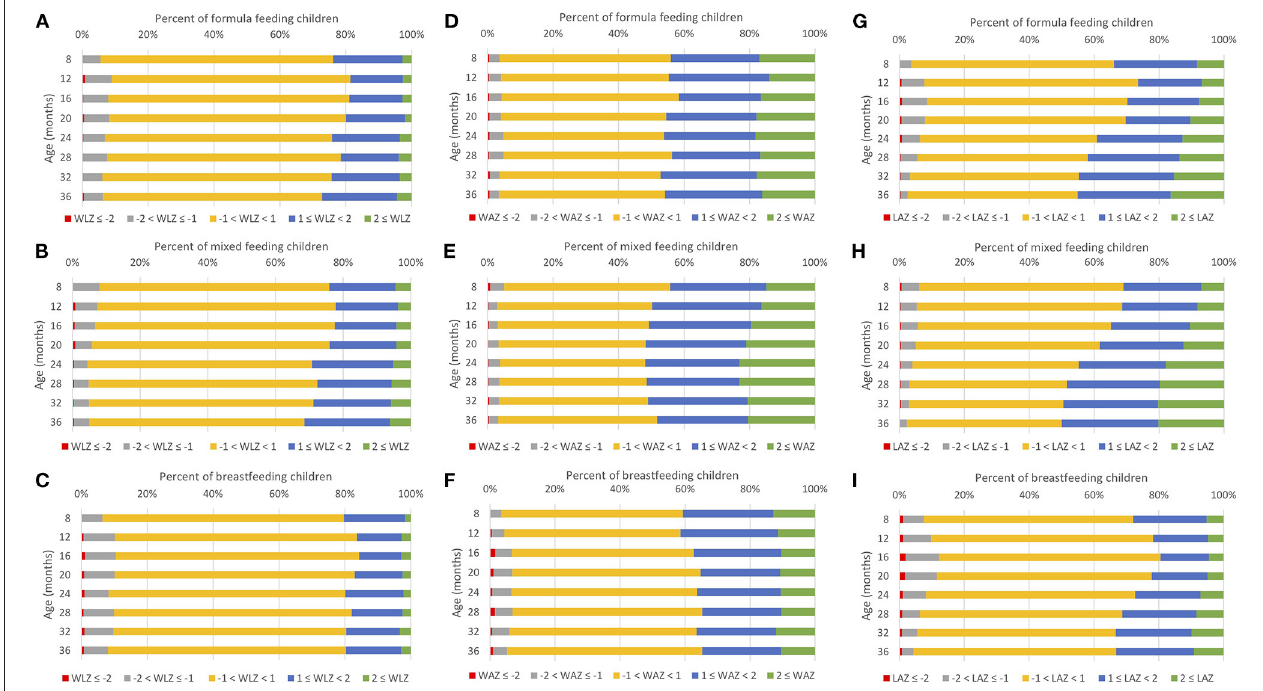
FIGURE 1 | Prevalence of anthropometric index percentile categories a by infant package received at 7 months for WIC-participating children from ages 7 to 38 months in Los Angeles County, 2009–2016 ( N = 16,255). (A) Formula feeding, WLZ, (B) Mixed feeding, WLZ, (C) Breastfeeding, WLZ, (D) Formula feeding, WAZ, (E) Mixed feeding, WAZ, (F) Breastfeeding, WAZ, (G) Formula feeding, LAZ, (H) Mixed feeding, LAZ, (I) Breastfeeding, LAZ. a Categories were defined by z-scores for each anthropometric index: z ≤ 2, − 2 < z ≤ − 1, − 1 < z < 1, 1 ≤ z < 2, 2 ≤ z. Age was categorized: 7 to < 10m (8 months), 10 to < 14 (12 months), 14 to < 18